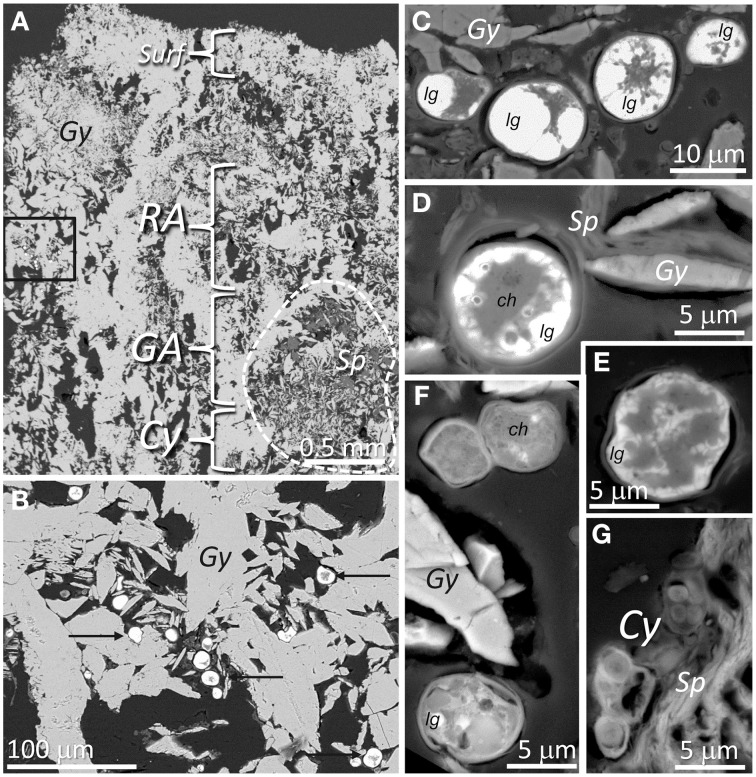
SEM-BSE images of the gypcrete top zone with cryptoendolithic microbial habitat. (A) Image shows surface (Surf) dense layer, orange-color algae colonization zone (RA), green algae (GA) colonization zone, and cyanobacteria (Cy) colonization zone close to sepiolite (Sp) nodules; square mark area shown in detail on figure (B), where black arrows point to alga cells between lenticular gypsum (Gy) crystals. (C–F)
In situ images showing algal cells among gypsum (Gy) crystals from higher to lower position within the colonization zone with clearly distinguishable ultrastructural elements such as lipoidal globules (lg) and chloroplasts (ch). (G) Image of cyanobacteria cells (Cy) in direct contact with sepiolite (Sp).